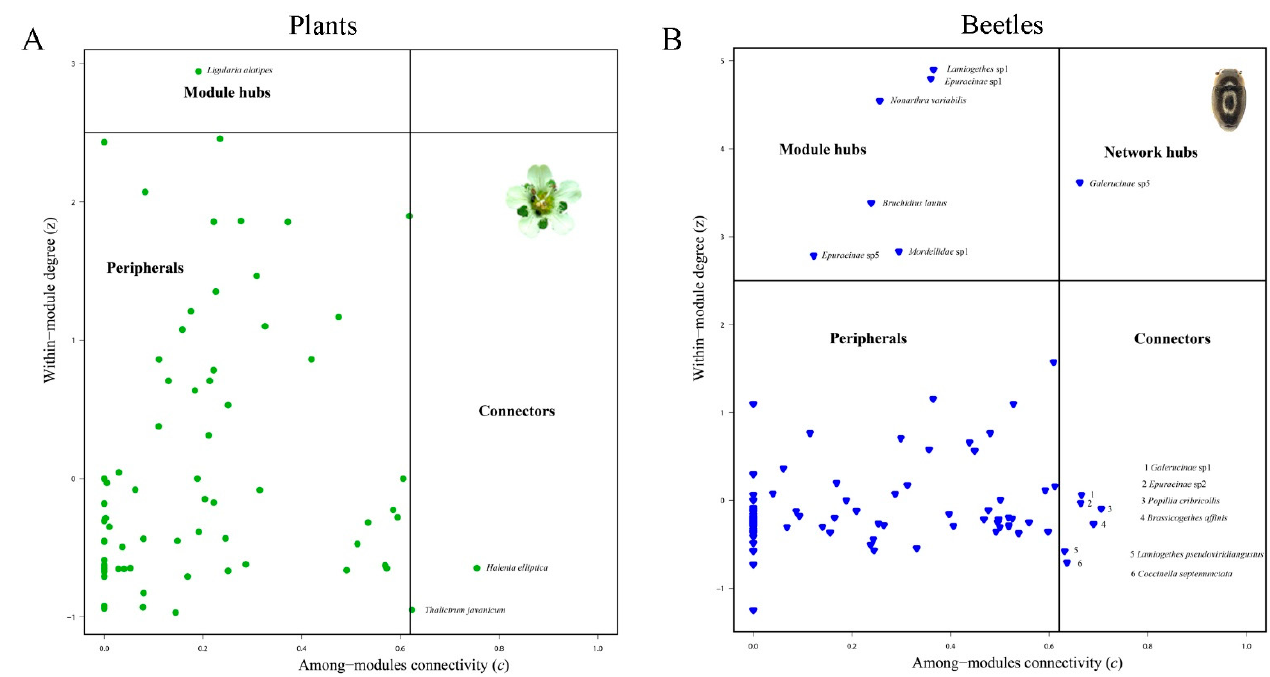
Figure 4. Species roles in the total network. ( A ). No network hub was detected for plants, while three species Ligularia alatipes Hand.-Mazz. (Asteraceae), Halenia elliptica D. Don (Gentianaceae) and Thalictrum javanicum Bl. (Ranunculaceae) were detected as module hubs. ( B ). One beetle species Galerucinae sp.5 (Chrysomelidae) was detected as a network hub. Six species were detected as module hubs, and six species (marked as 1–6) as connectors.